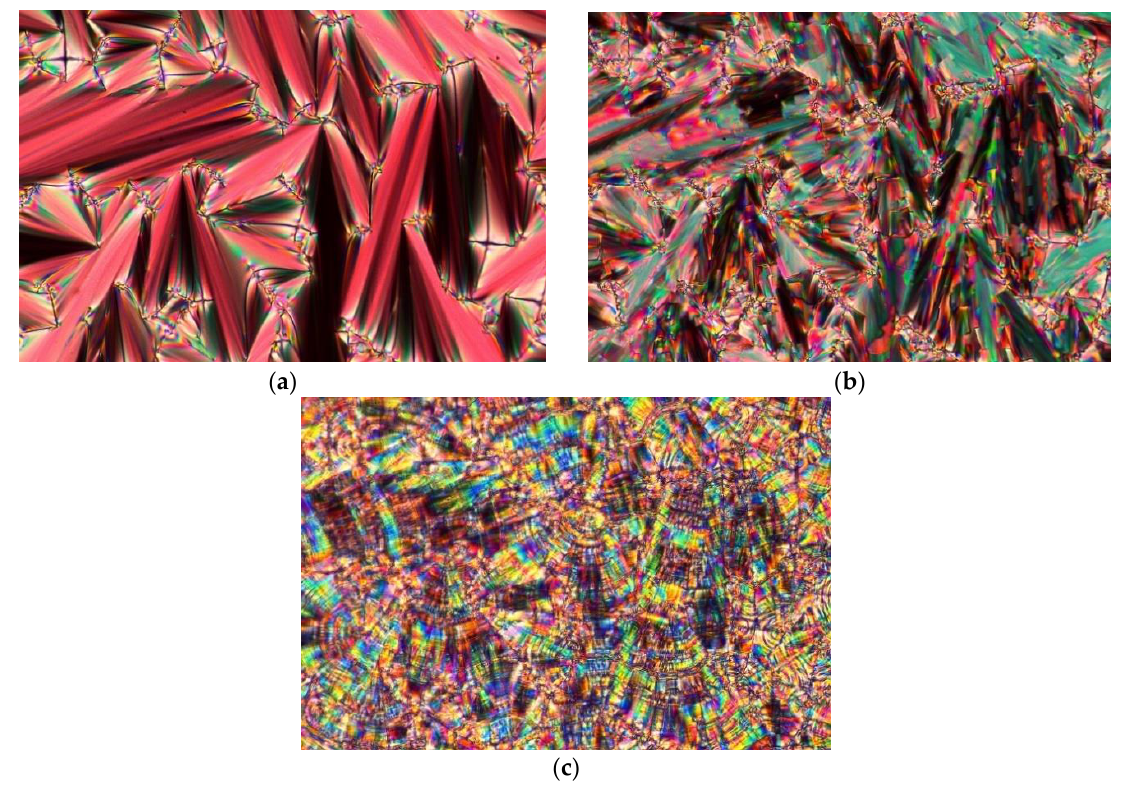
Figure 4. The textures of the smectic phases obtained in the cooling cycle for the racemic mixture 7.(HH) (R,S) . ( a ) The SmA phase at 140.5 °C; ( b ) The SmC phase at 130.7 °C; ( c ) The SmC A phase at 98.2 °C.